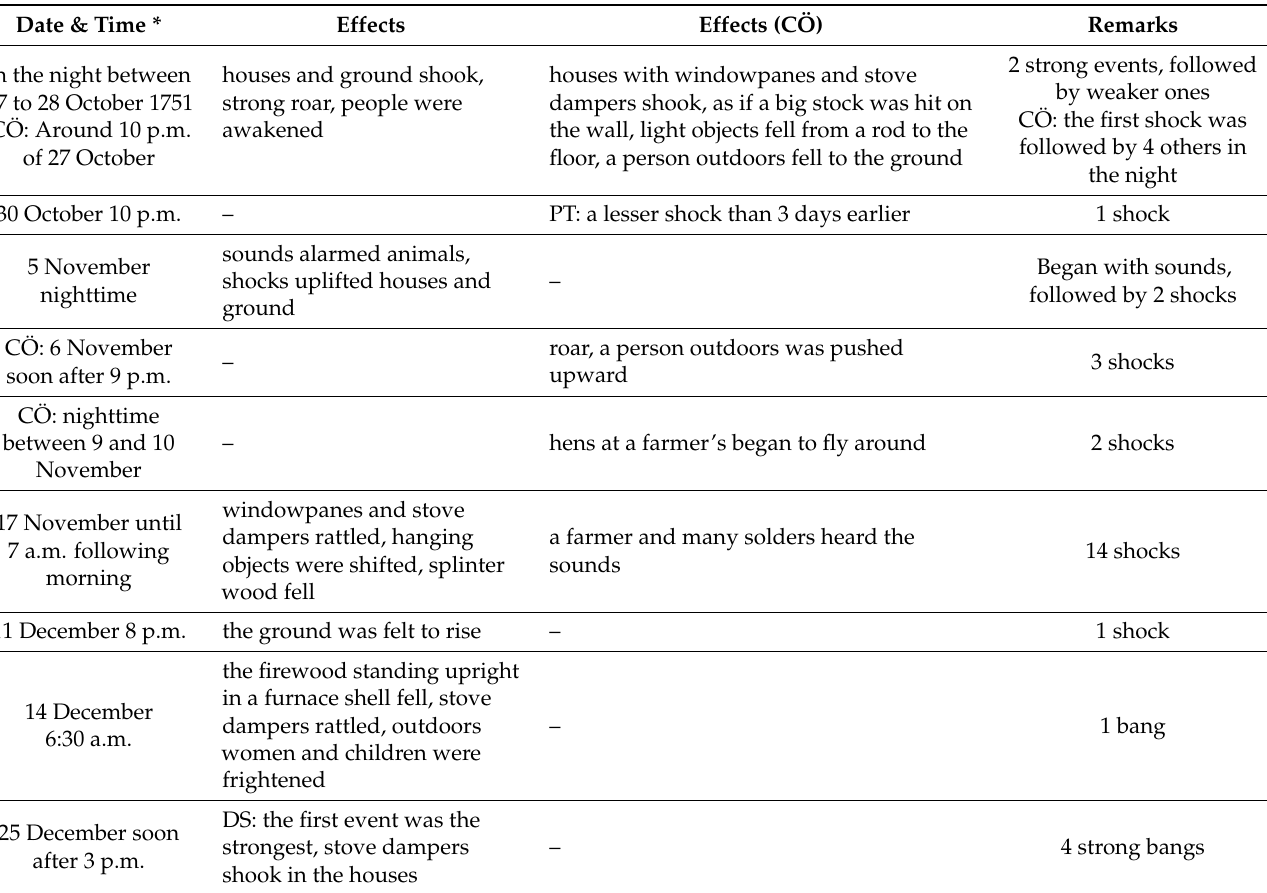
Table 1. A descriptive catalog of the reported events. The contents by default follow Carl Johan von Holthusen’s testimony. CÖ refers to the report by Carl Östberg, DS to that of David Starck, PT to the newspaper Stockholms Post-Tidningar on 30 December